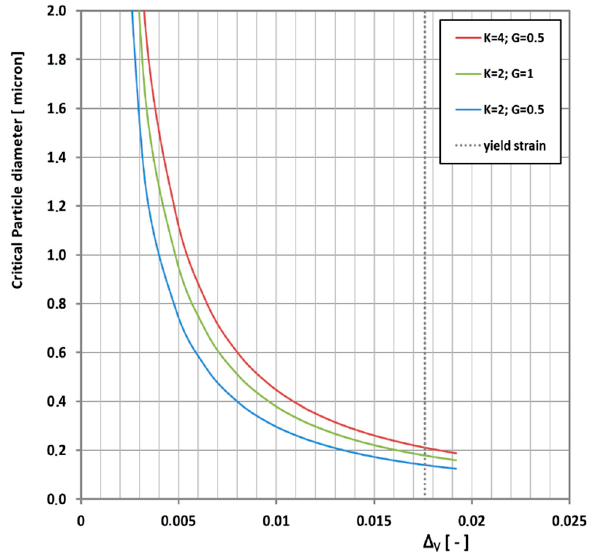
Figure 8. Critical particle size for cavitation according to Equation (10) for a collection of bulk and shear moduli. The grey vertical dotted line is the matrix yield strain, beyond which there is no hydrostatic cavitation stress.